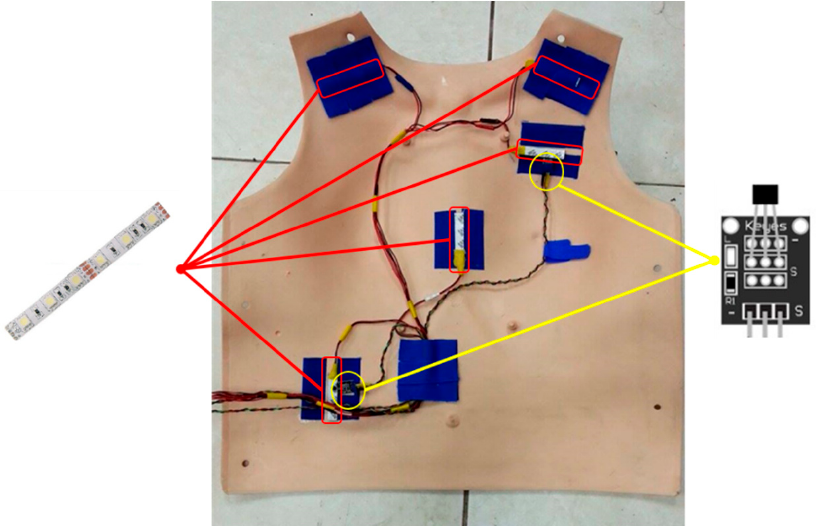
Figure 19. The magnetic sensors and LED indicator bars installed beneath the skin of the manikin.